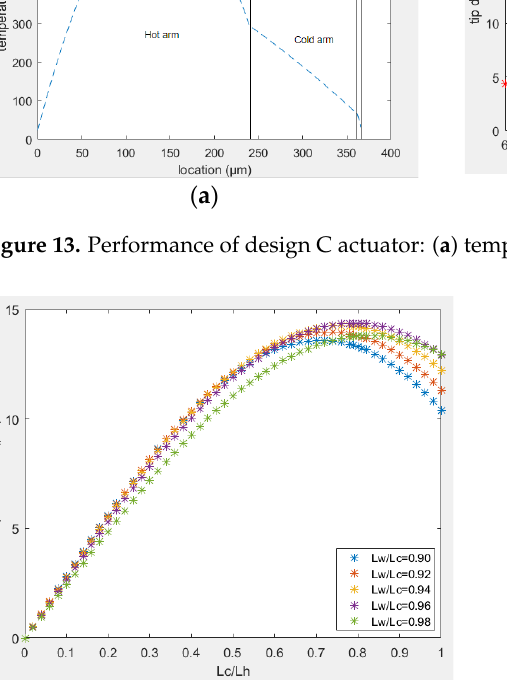
Figure 13. Performance of design C actuator: ( a ) temperature distribution; ( b ) tip deflection.